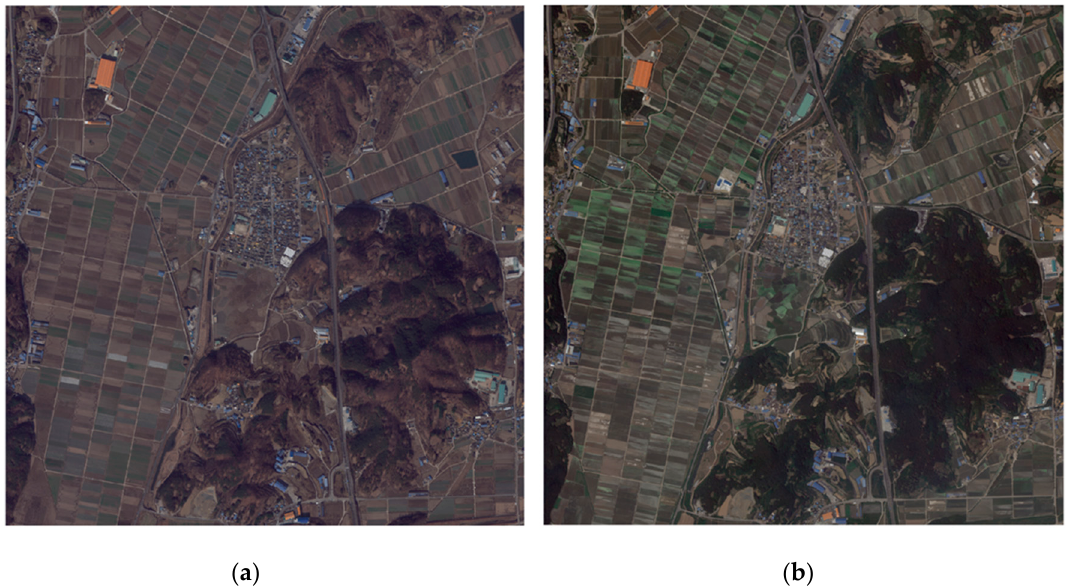
Figure 2. The experimental images from site 2: ( a ) subject image acquired on 30 October 2015, ( b ) reference image acquired on 18 June 2016.